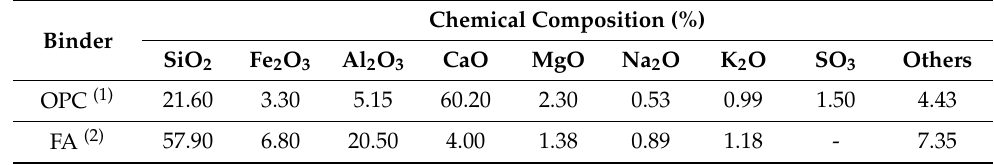
Table 1. Chemical compositions of the binders used.